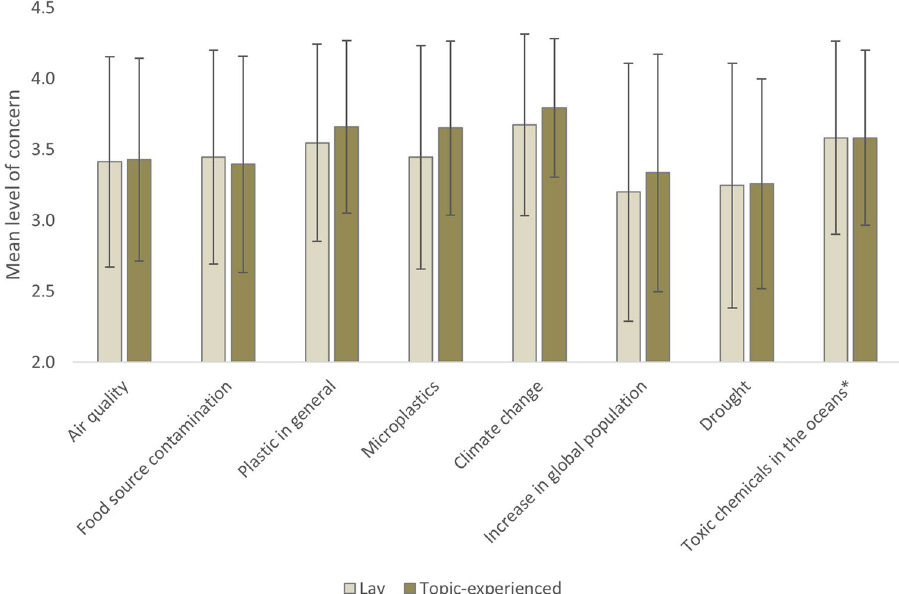
Figure 1. Mean level of concern (± standard deviation) of selected environmental issues of lay respondents (n = 1430) compared to topic-experienced^ respondents (n = 251). Survey results obtained in 2018/2019. *such as pesticides or heavy metals. ^acknowledged their previous or current work on the topic of plastics and/ or microplastics as an environmental contaminant or involvement in a research project on this topic. Levels